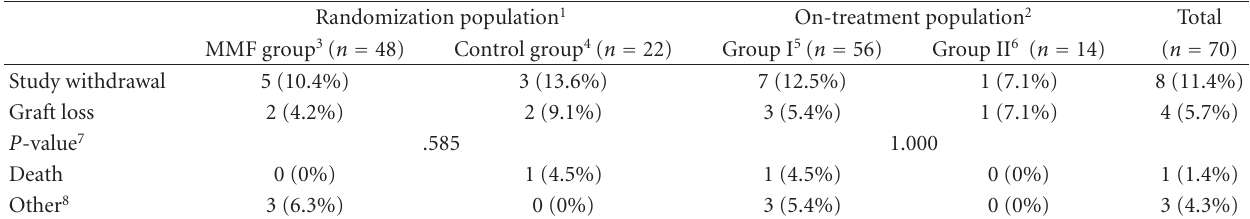
Table 1: Study withdrawal and reason for withdrawal.